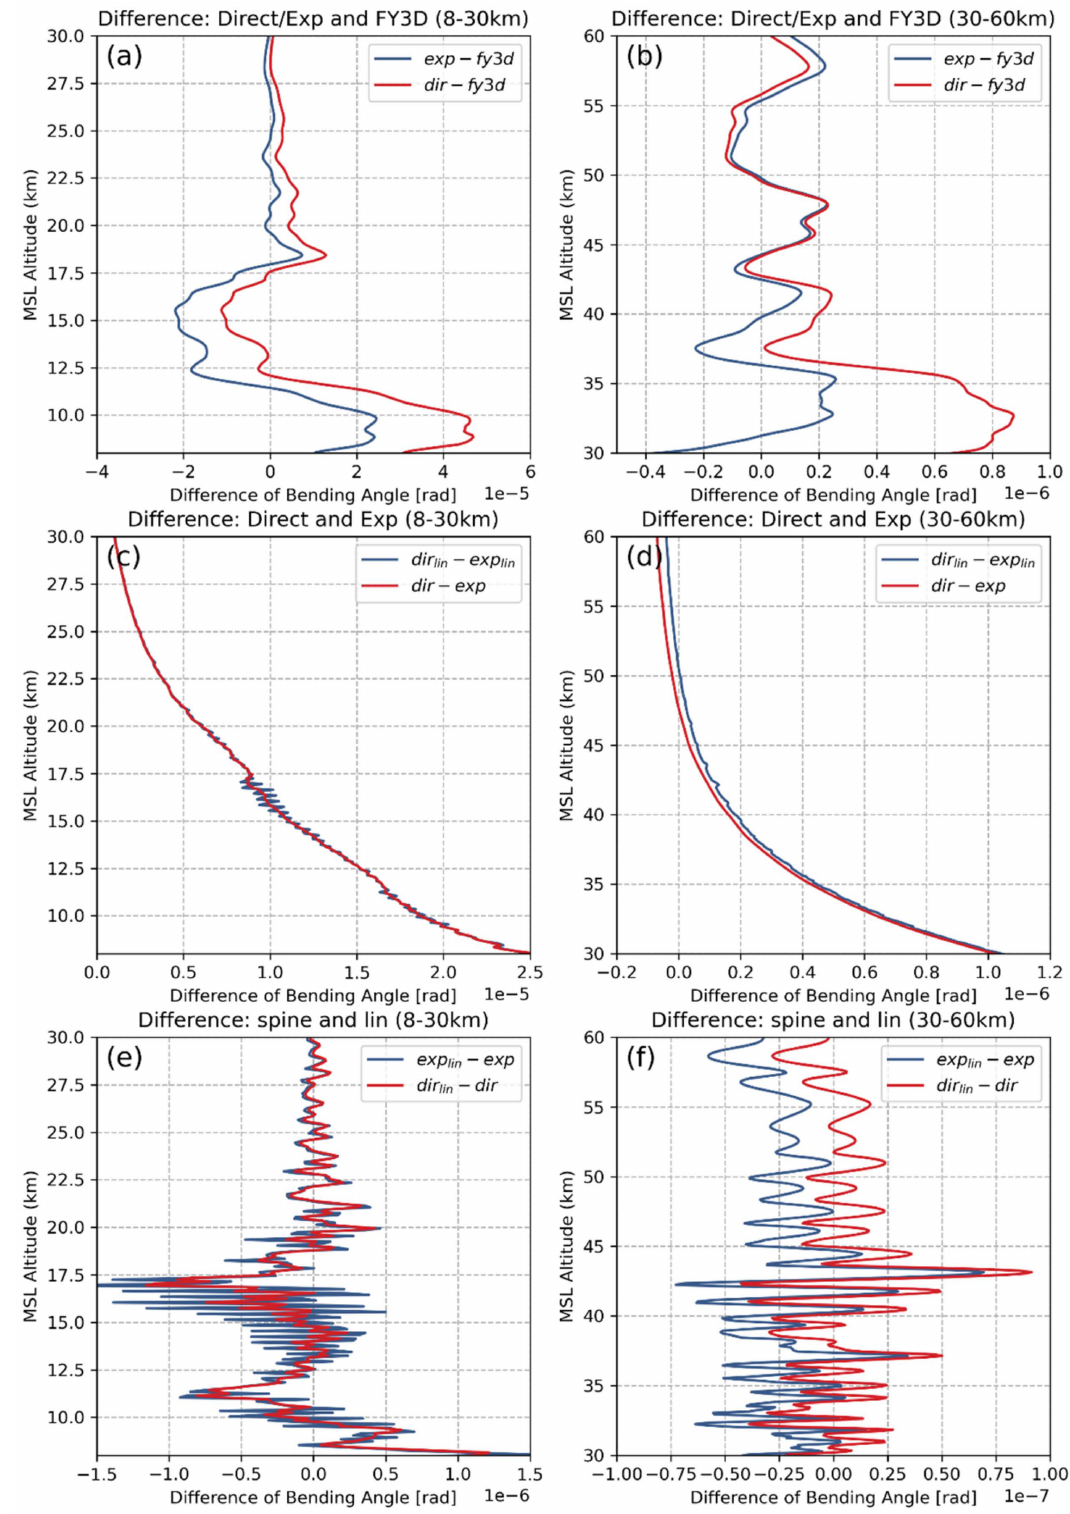
Figure 3. Difference between the BA of FY3D (T) and EC4Dvar BA (E) using the direct and exp Abel integral algorithms, together with log-linear and log-cubic interpolation methods. ( a , b ) (E exp/dir − T) using the log-cubic interpolation; ( c , d ) difference of the Abel integral algorithms (E dir − E exp ) based on the log-linear and log-cubic interpolation, respectively; ( e , f ) difference of interpolation methods (E lin − E) based on exp and direct Abel integral algorithms,